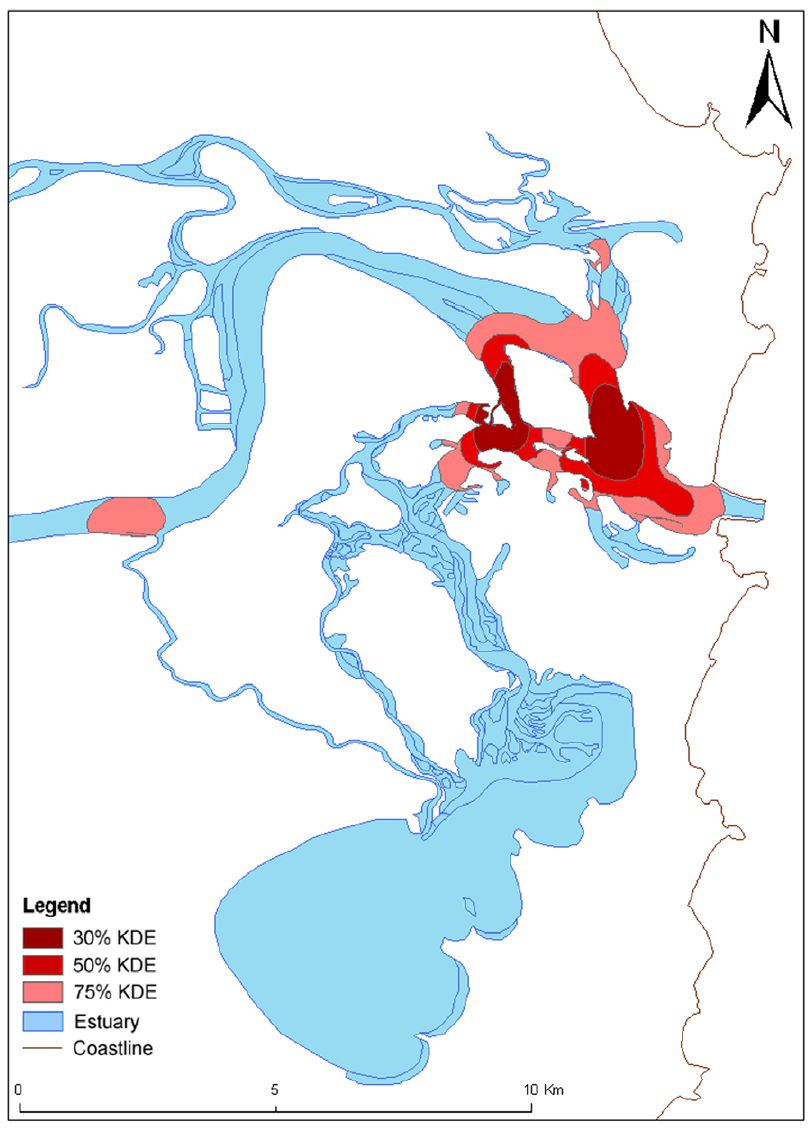
Figure 6. Mixed-sex groups’ kernel density estimates (KDE) displaying aggressive coercive behaviour in the Clarence River estuary (N=336).